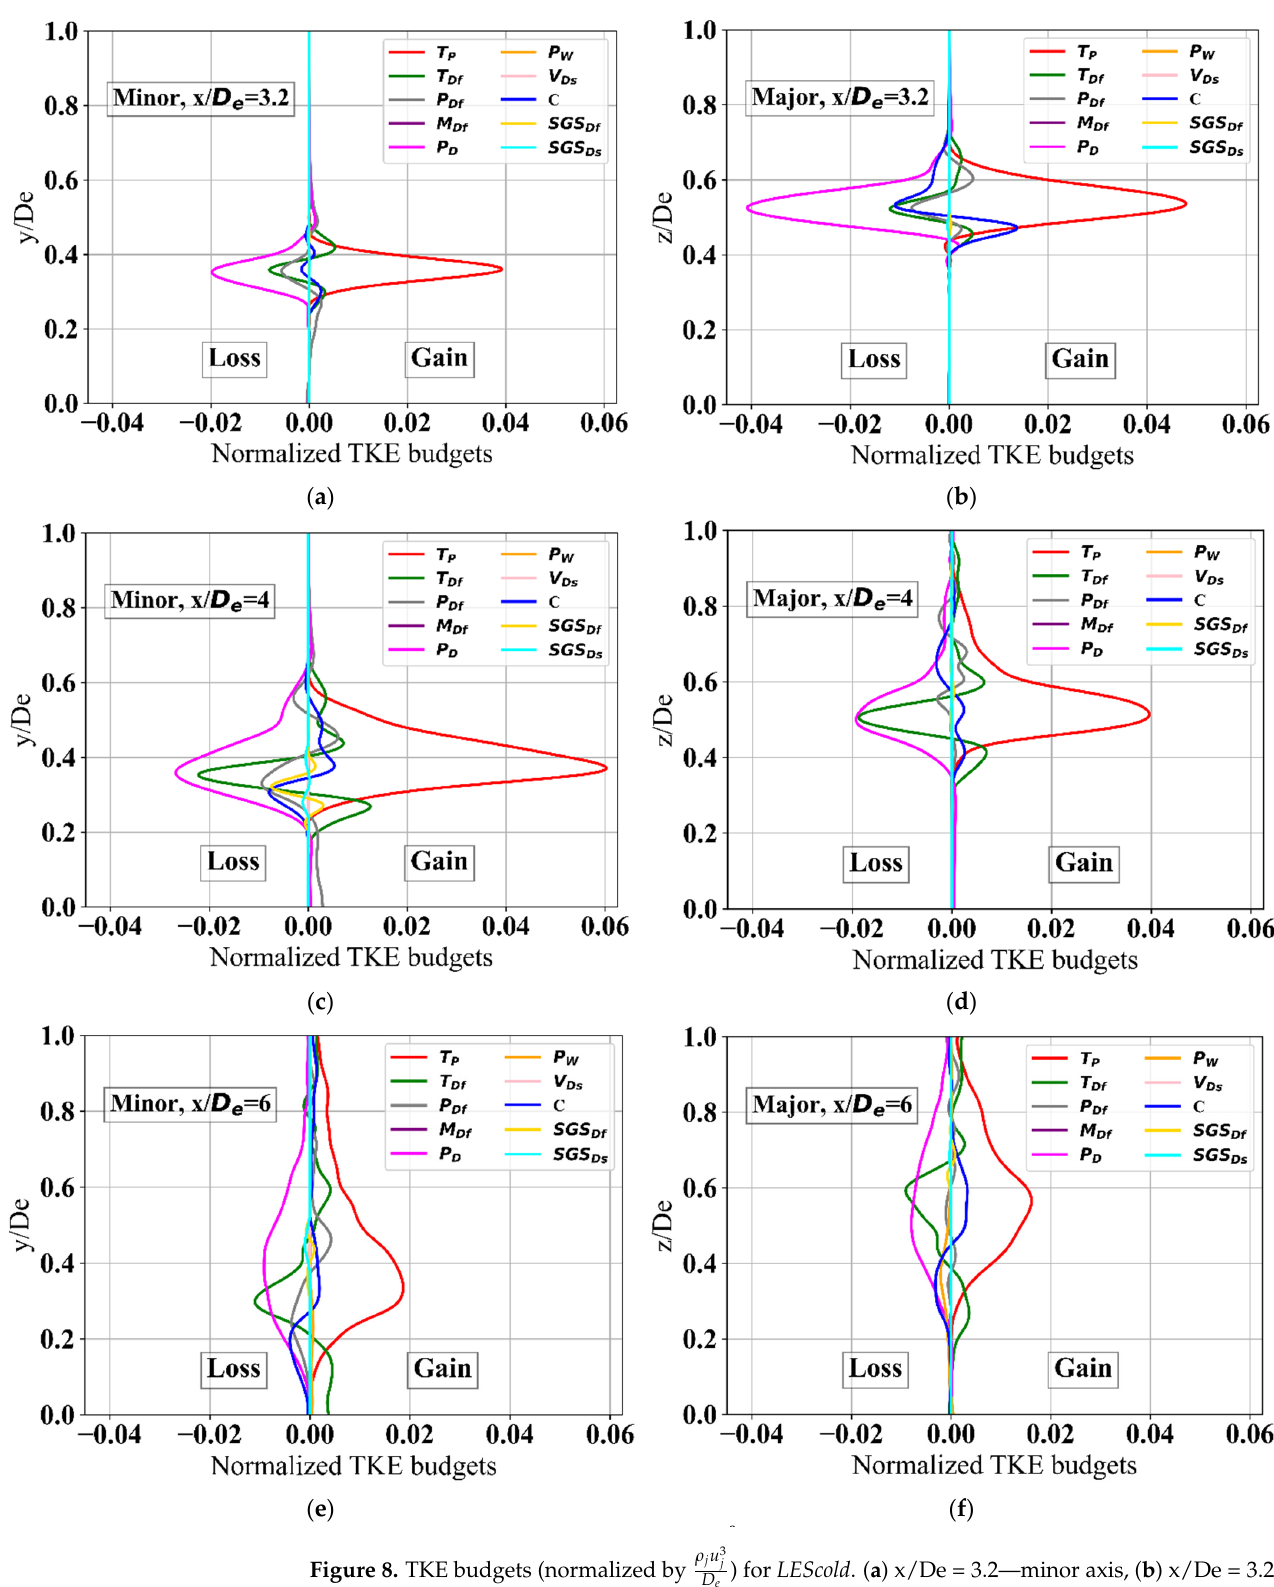
Figure 8. TKE budgets (normalized by major axis, ( c ) x/De = 4—minor axis, ( d ) x/De = 4—major axis, ( e ) x/De = 6—minor axis, ( f ) x/De = 6—major axis.